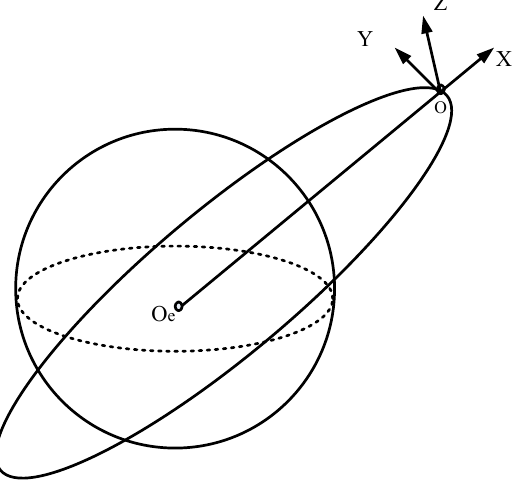
Figure 1. The Orbital Coordinate System.